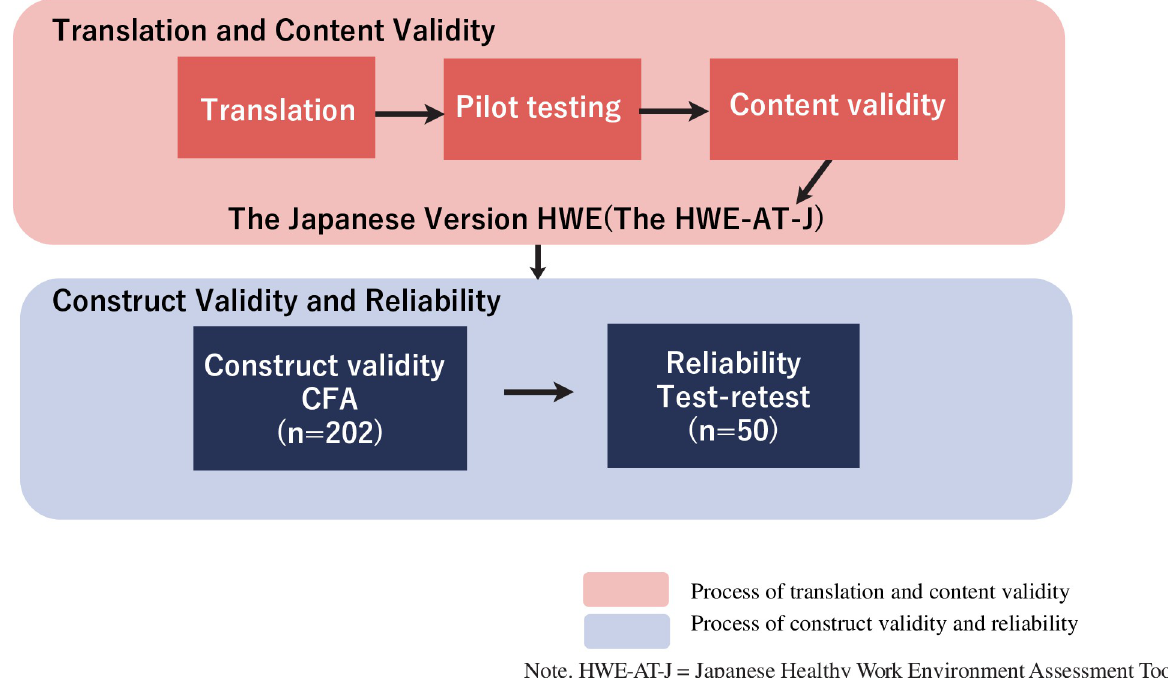
Fig 1. Summary of the HWE-AT-J development. First, the HWE-AT-J was developed through translation and content validation. And then construct validity and reliability were conducted.